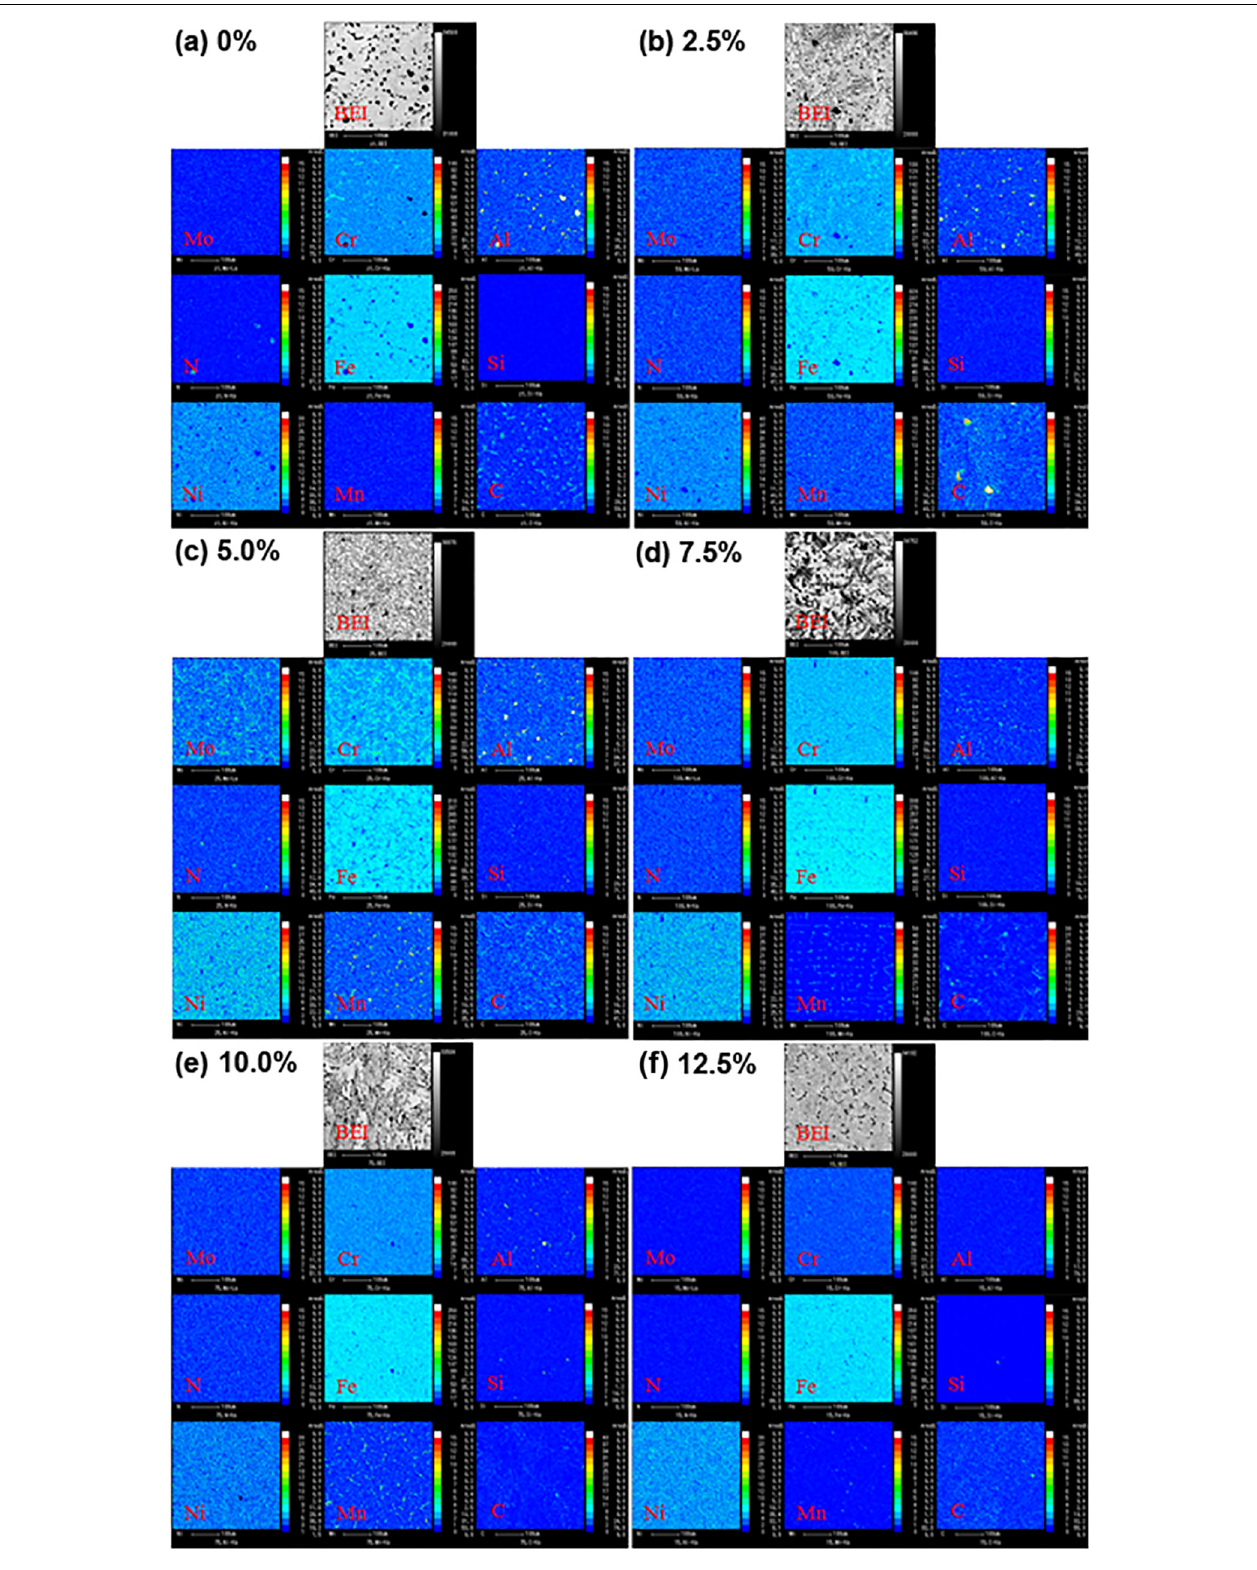
FIGURE 3 | EPMA backscattered electron images (BEIs) of 2205 DSS prepared with different Fe 2 O 3 excess percentages and their corresponding element mappings: (a) 0%, (b) 2.5%, (c) 5.0%, (d) 7.5%, (e) 10.0%, and (f) 12.5%.